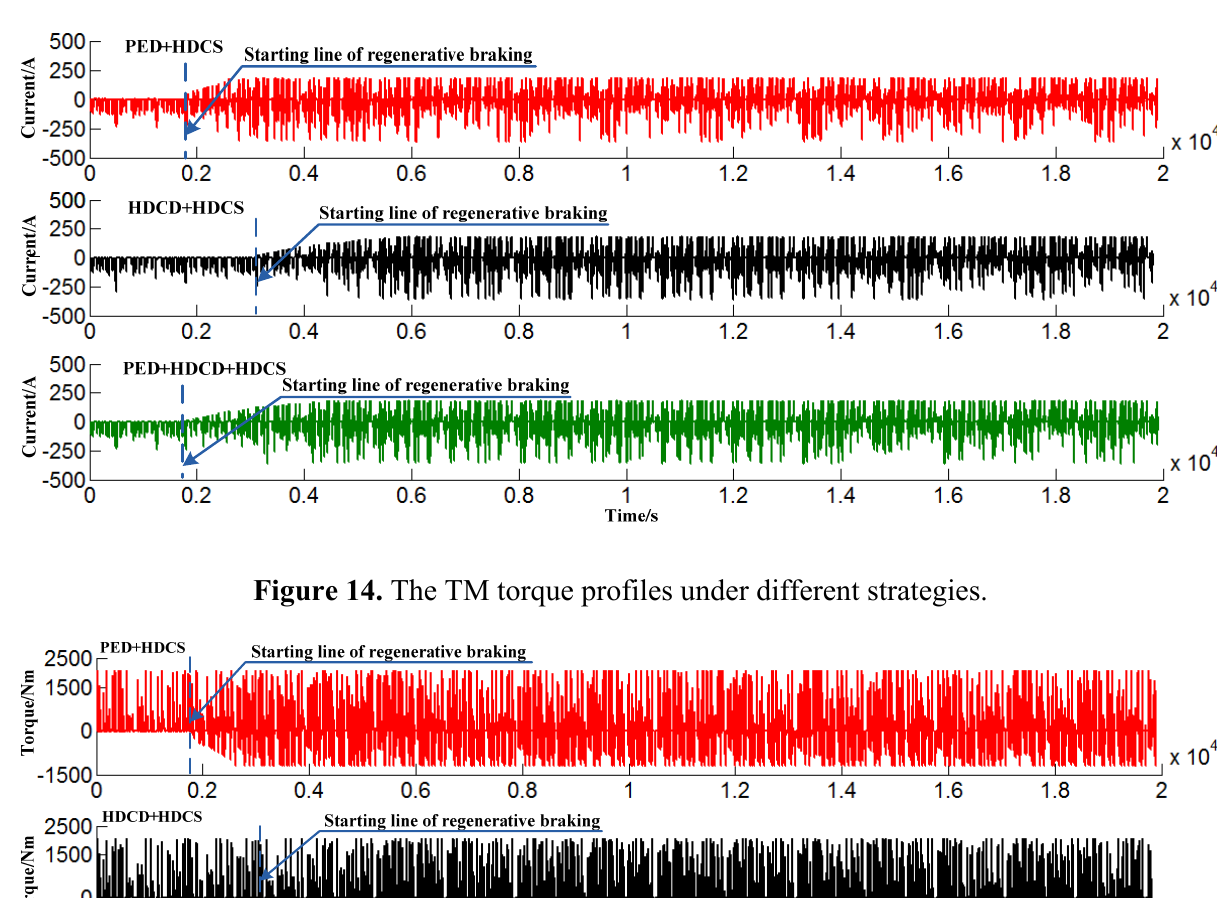
Figure 13. The battery current profiles under different strategies.